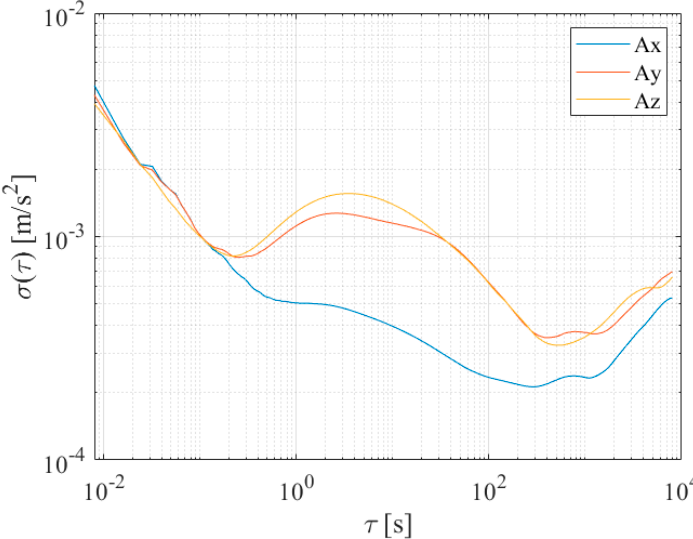
Figure 7. Allan deviation of accelerometers along the three sensing axes of the prototype.